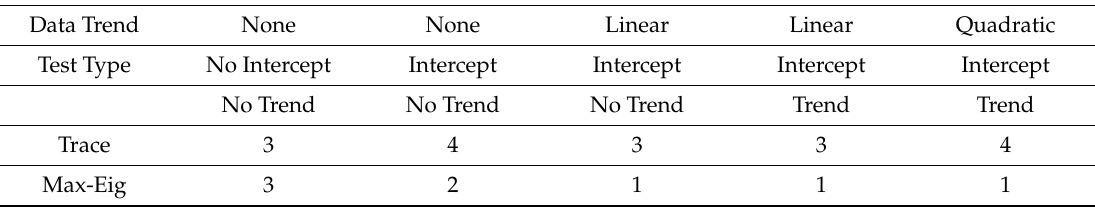
Table 13. Johansen Cointegration